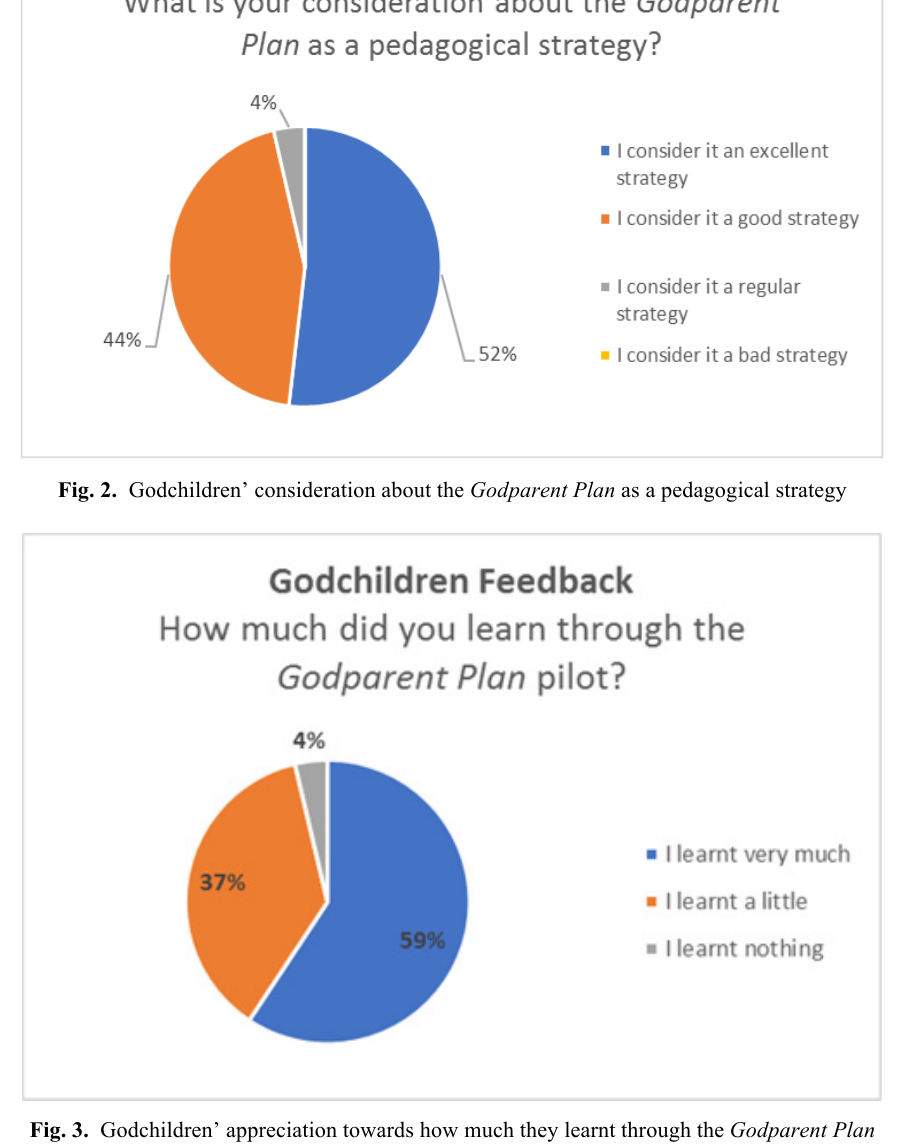
Fig. 3. Godchildren’ appreciation towards how much they learnt through the Godparent Plan